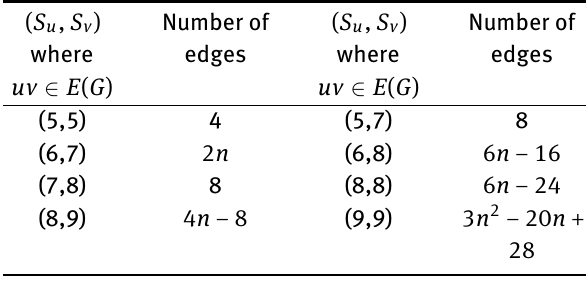
Table 4: The edge partition of the graph Bsw ( P n ) ( S , S ) u v